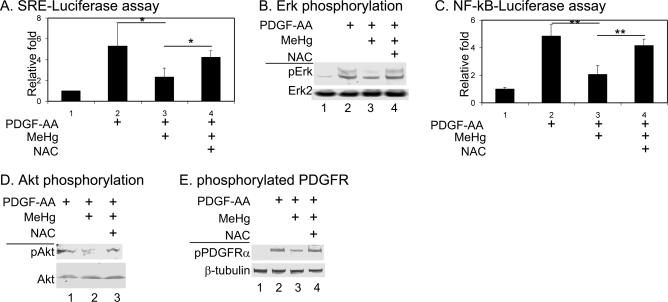
MeHg Suppresses PDGF-Mediated Signaling from the Nucleus Back to the Receptor(A) Progenitors transfected with an SRE-luciferase reporter construct and exposed to 30 nM MeHg (24 h) showed significantly lower levels of reporter activity. *, p < 0.05.(B) Cells grown as in (A) and analyzed for phosphorylation of ERK1/2 showed reduced ERK1/2 phosphorylation.(C) Cells transfected with an Nf-κB-luciferase reporter construct and treated as in (A) showed reduced Nf-κB transcriptional activity. **, p < 0.01.(D) Cells grown as in (A) showed lower levels of Akt (Thr 308) phosphorylation.(E) Cells grown as in (A) also showed decreased phosphorylation of PDGFRα (as detected with anti-PDGFRα(pY742) antibody). All effects of MeHg were prevented by growth of cells in the additional presence of 1 mM NAC.All experiments were repeated at least three times, and all numerical values represent means ± SD for triplicate data points. The plus symbol indicates exposure of the cells to the indicated substance.